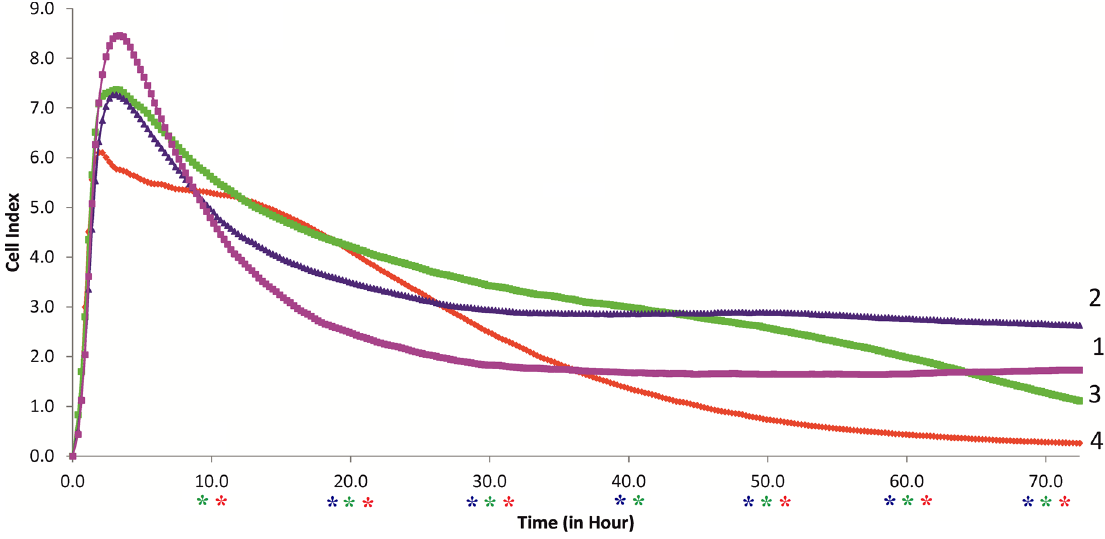
Figure 4. xCELLigence cell index impedance curves for hAMSCs contacted with different ratios of microcapsules in E-plate: 1 control hAMSC culture (40,000 cells) incubated without microcapsules (1:0); 2 – 4 cells contacted with 5 (1:5), 10 (1:10), and 20 (1:20) microcapsules per cell, respectively. Each curve represents the mean value of the cell index from 4 wells. The individual curves with the mean values ± SD are shown in Figure S4. *—statistical differences with control group according to the Mann–Whitney test; the color of asterisks corresponds to the color of group (blue—2, green—3, and red—4).